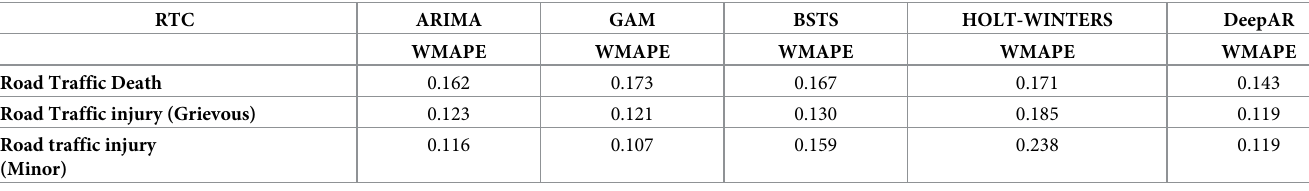
Table 3. Validation error (WMAPE) of five models for the unseen data (January 1, 2020 to March 22, 2020).